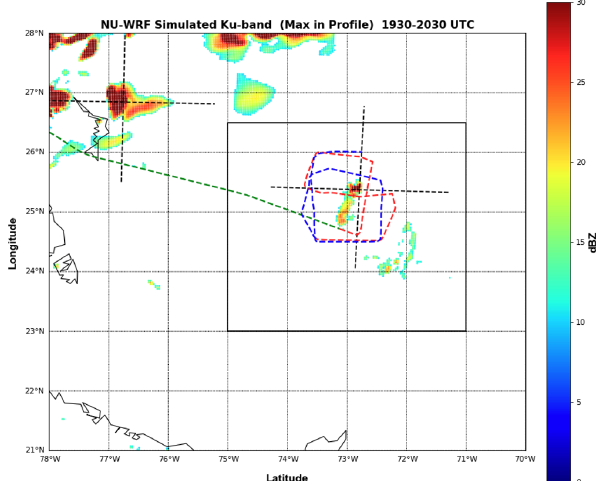
Figure 7. Plan view of NU-WRF simulated Ku-band reflectivity (shown as maximum reflectivity in the profile) from the NU-WRF analysis at 20:00UTC. The dashed lines indicate the locations of the E–W and N–S cross sections shown in Fig. 8, crossing at locations 26.8 ◦ N, 76.8 ◦ W and 25.5 ◦ N, 72.9 ◦ W. The green, red, and blue dashed lines indicate the DC-8 flight tracks between 18:30–19:30, 19:30–20:30, and 20:30–21:30UTC, respectively.